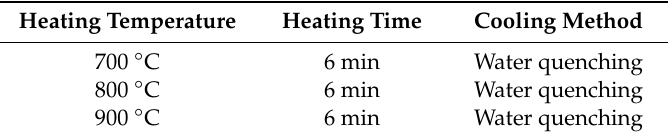
Table 2. Experimental plan of the thermal simulation tests.